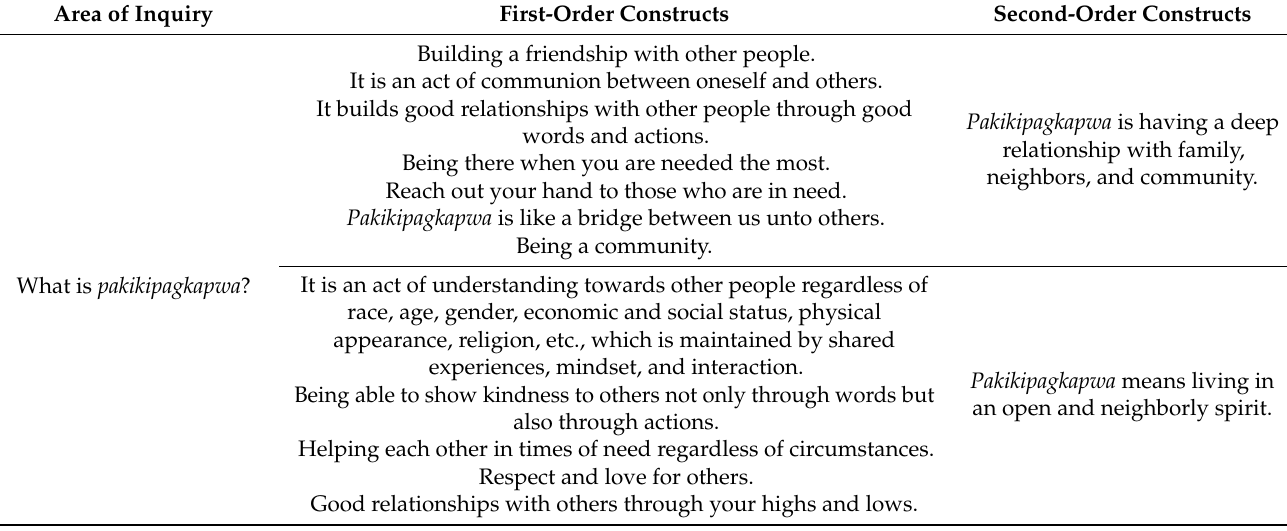
Table 2. Notions of select Filipino Christians on pakikipagkapwa .